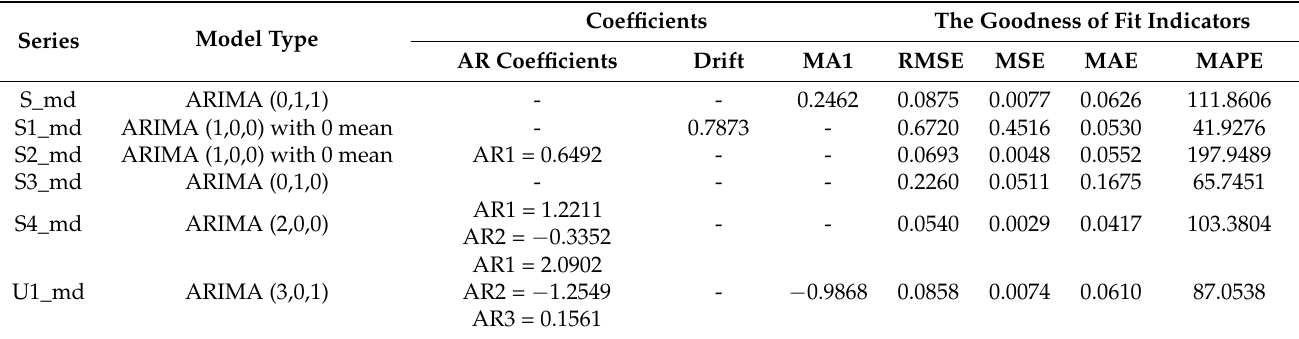
Table 18. ARIMA models for monthly detrended